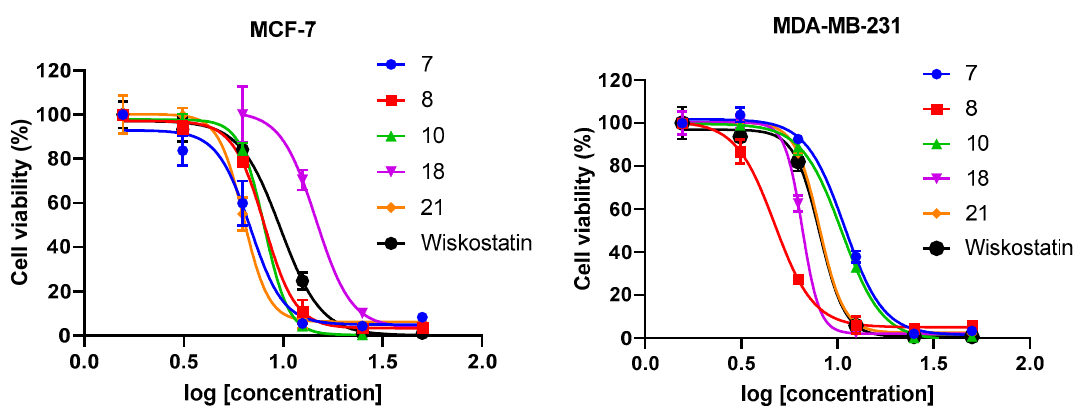
Figure 2. Log-dose response curve for compounds 7 , 8 , 10 , 18 , 21 , and Wiskostatin on MCF-7 and MDA-MB-231 breast cancer cell lines. Each data point represents the mean of three replicates and error bars represent ± SD. Each GI 50 value was calculated based on sigmoidal curve fitting to the respective data set.